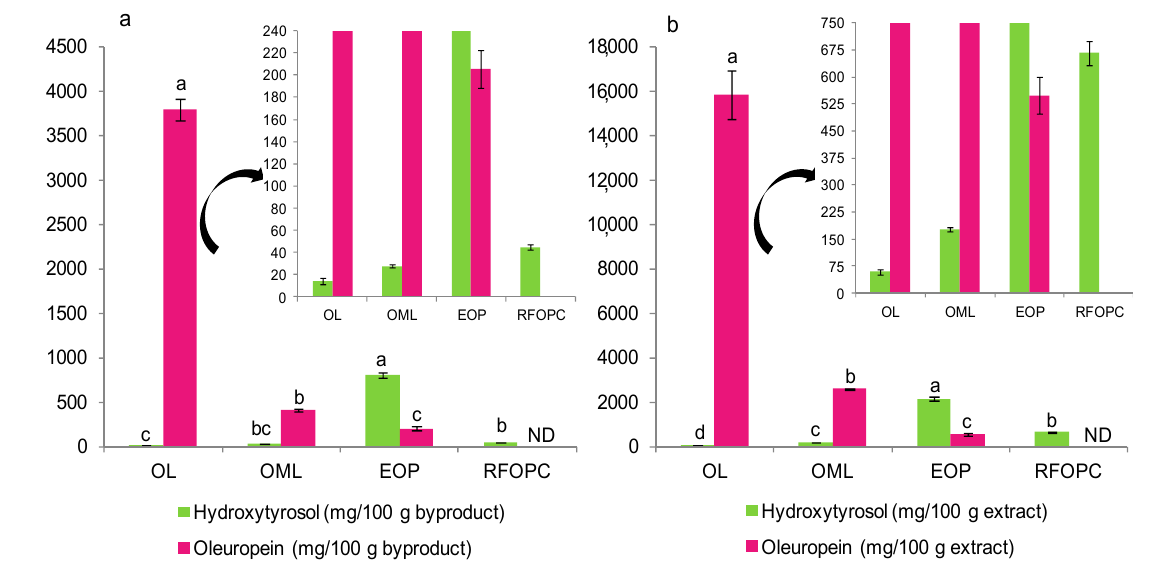
Figure 4. Content of hydroxytyrosol and oleuropein in olive byproducts in terms of: ( a ) Byproduct weight (d.w.) and ( b ) extract weight (d.w.). For each compound, different lowercase letters indicate significant differences between the samples ( p < 0.05). ND, not detected.